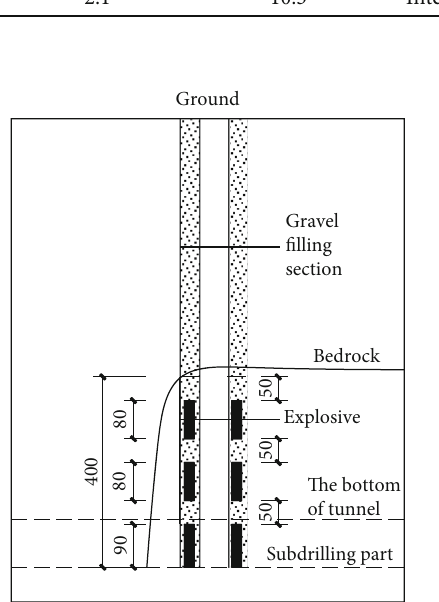
Figure 8: Schematic diagram of bedrock charge